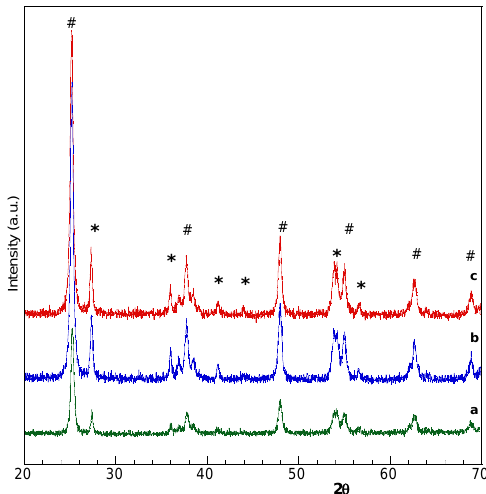
Figure 1. X-ray diffraction (XRD) patterns of samples based on TiO 2 P25: ( a ) 1.0CCu / P25; ( b ) 1.0DCu / P25;.( c ) 1.0 ICu / P25; # TiO 2 Anatase (JCPDS, card. 21-1272); * TiO 2 Rutile (JCPDS, card 21-1276).